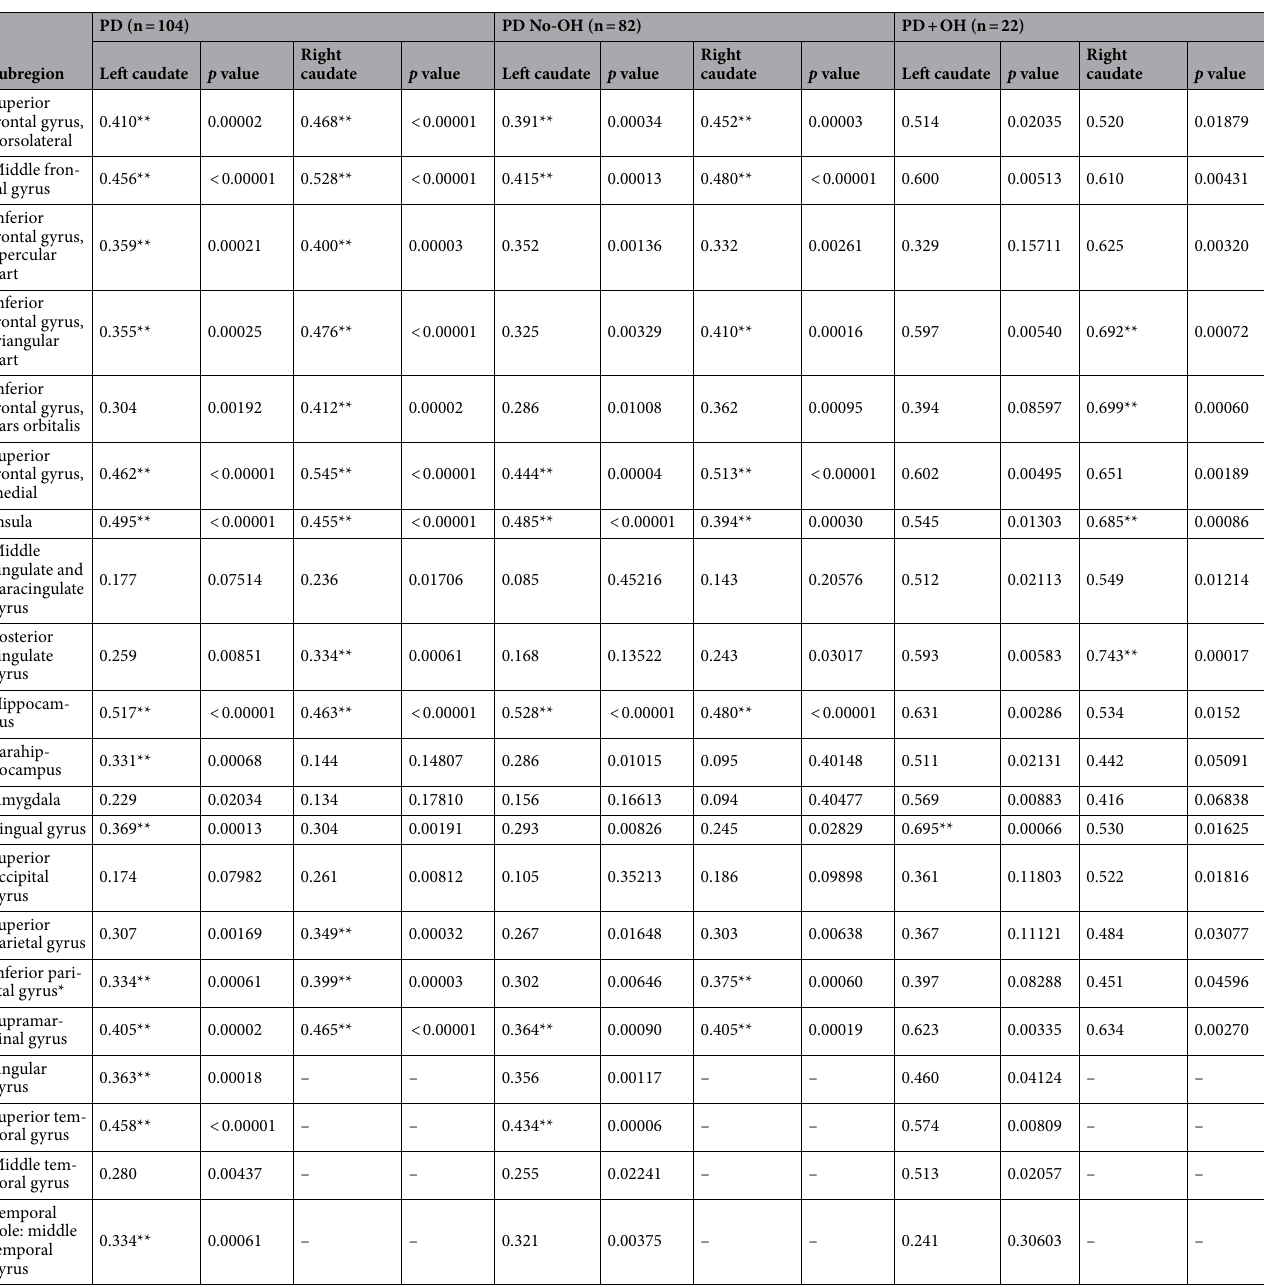
Table 2. Spearman partial correlation coefficients of prespecified subregions. OH, orthostatic hypotension. *Supramarginal and angular gyrus are excluded. Spearman partial correlation coefficients, partialized by age and disease duration, were calculated. Each caudate (seed ROI) was only correlated to ipsilateral subregions, i.e., left caudate’s correlations with left hemispheric subregions. **Coefficients whose p value < 0.00094 (Bonferroni correction threshold: < 0.05/53) were selected for further